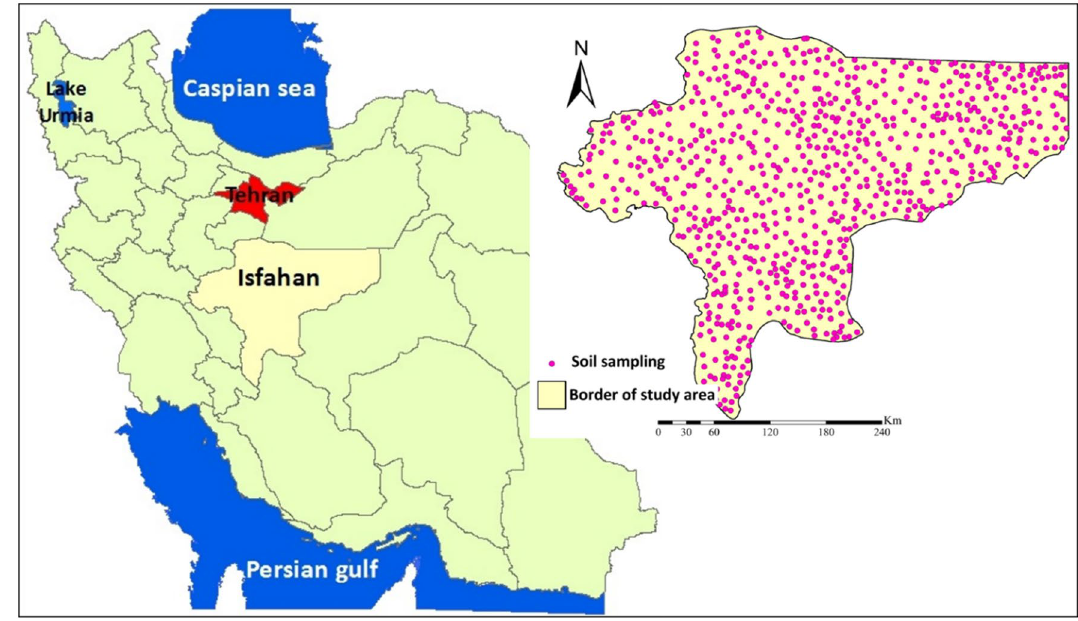
Figure 7. Location of the study area in Iran and sampling sites used for this study. Soil sampling sites were extracted from the world soil map 30 and then, these sites were mapped in ArcGIS 10.4.1 (https ://www.esri.com/ en-us/about /about -esri/overv